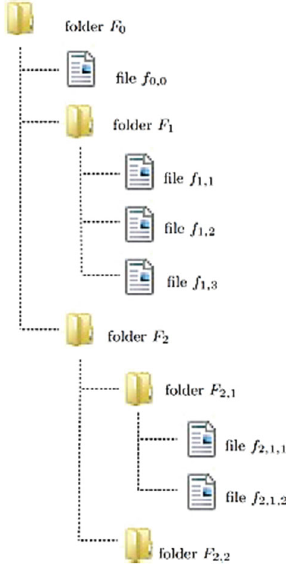
Fig. 4 Preferred tree-based structure to re-encrypt keys